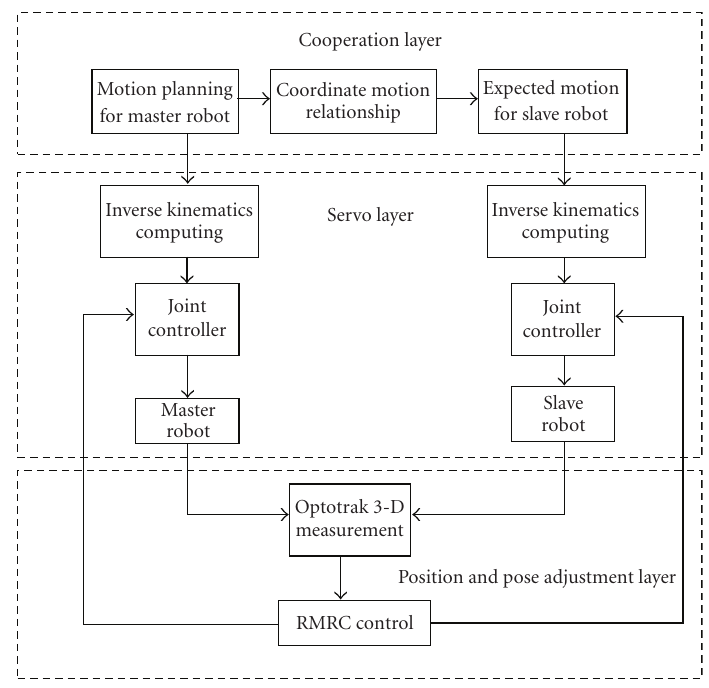
Figure 3: The hierarchical control structure diagram.